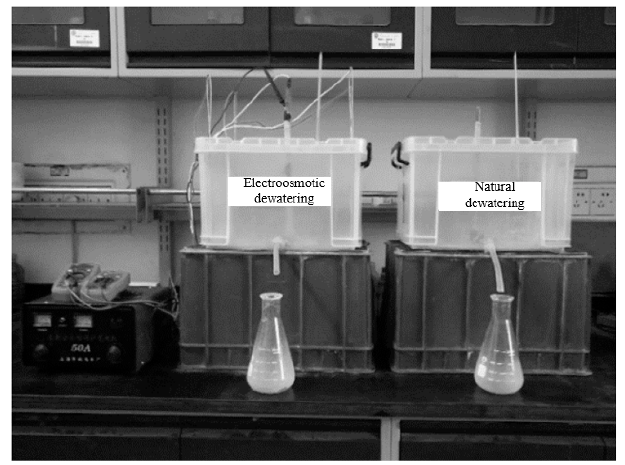
Figure 7. The test